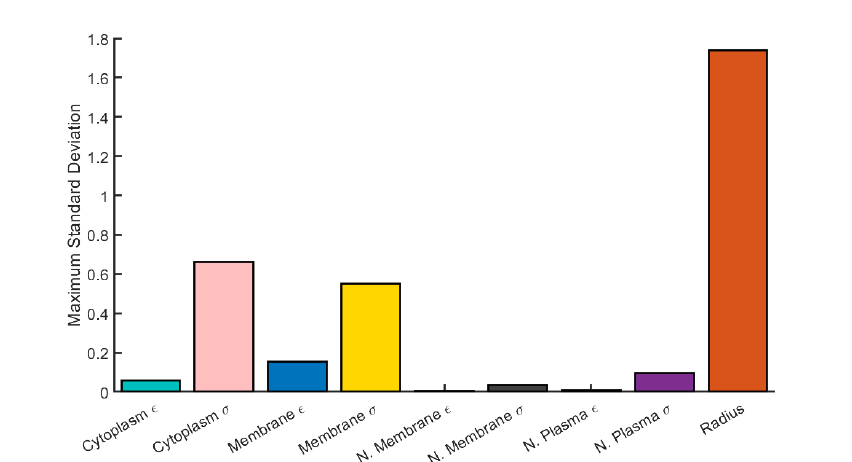
Figure 2. The maximum average variation in ∆ F DEP across all frequencies that arises from variations in radius and other electrical parameters in a 4-shell model for HEK cells. Model parameters are given in Table 1.